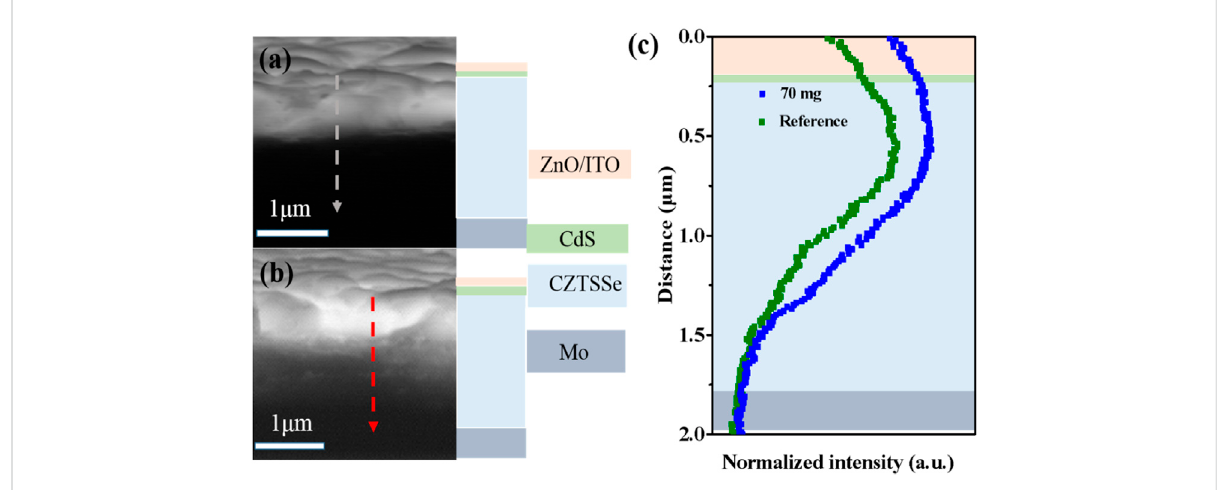
FIGURE 7 The EBIC images of pristine CZTSSe device (A) and Sb doped-CZTSSe device (B) , (C) is the corresponding normalized intensity pro fi ling along the dashed line in (A,B)